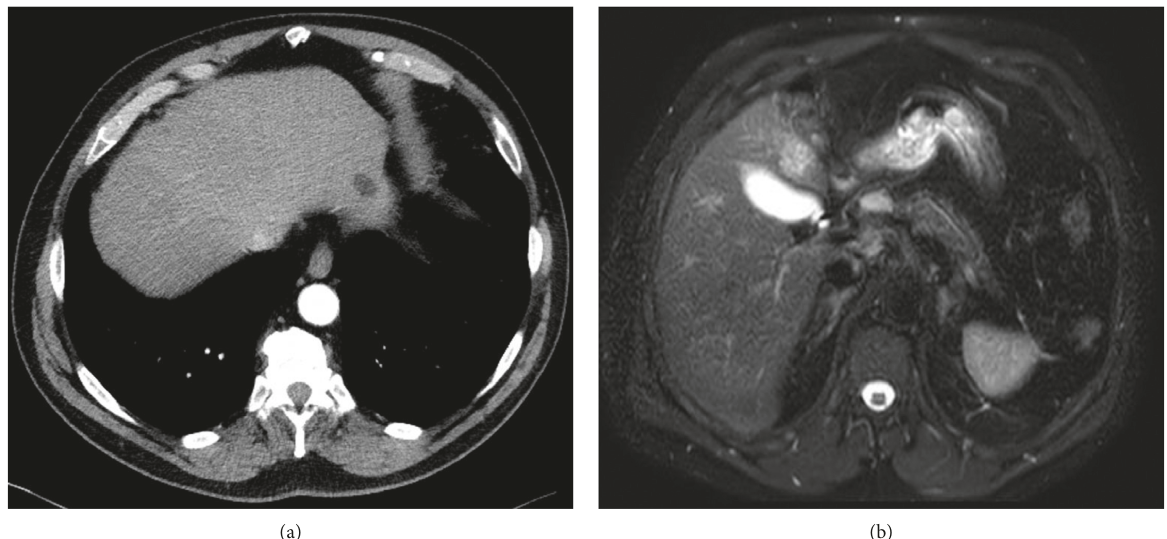
Figure 3: MRI abdomen showing 1.8cm liver cyst (a) and 1.3cm ovoid liver lesion